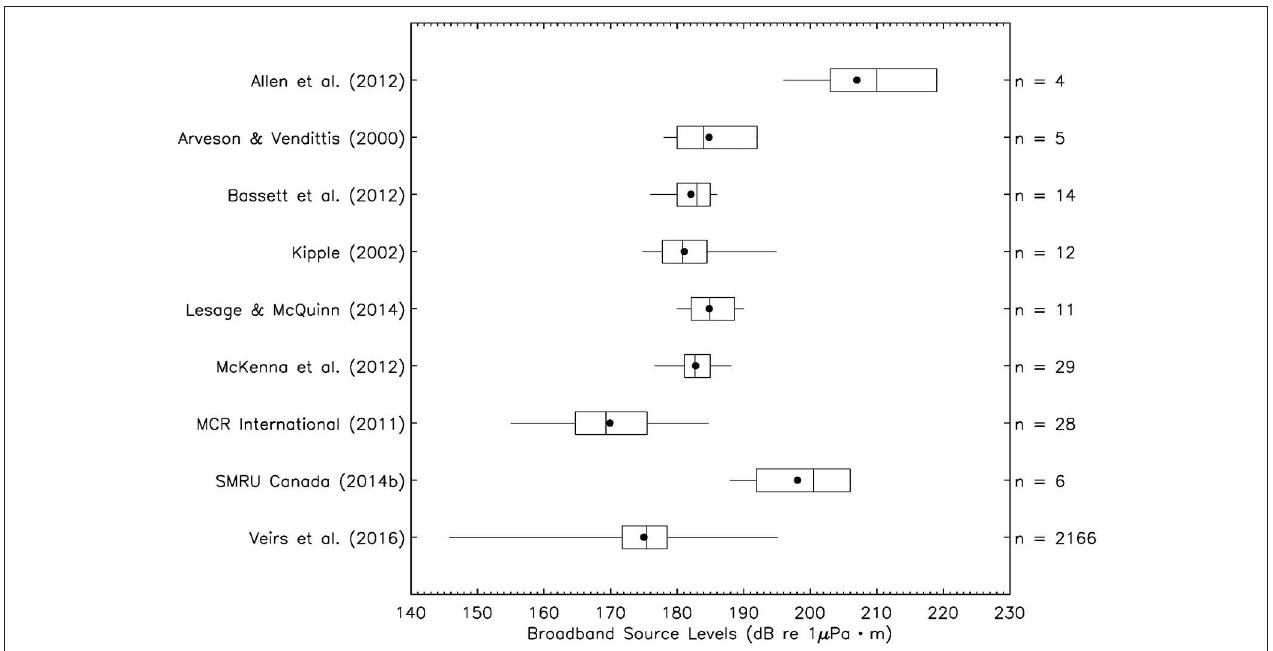
FIGURE 1 | Broadband source levels for merchant ships reported from studies listed in Table 1 . The right-hand ordinate provides the number of vessels with available data published in each work. Whisker plots show the minimal value, the 25, 50, 75% quartiles, the maximal value, and the mean () of each sample.